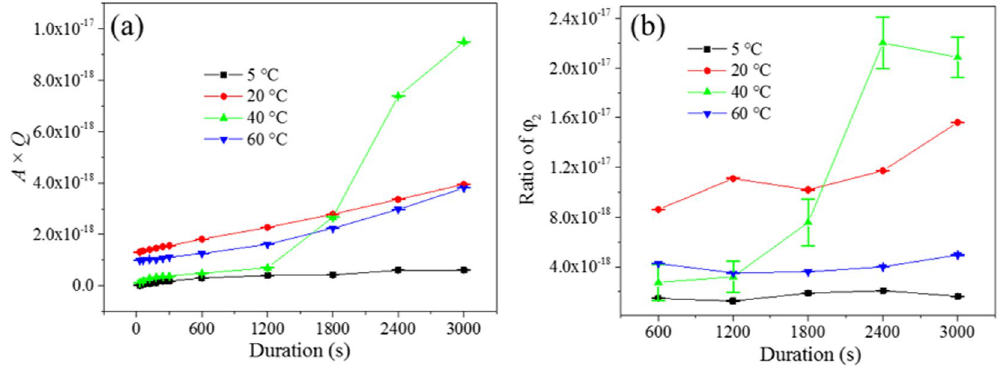
Figure 6. ( a ) Product of A * Q plotted against the process duration. ( b ) Calculated solid phase fragment ϕ 2 plotted against the process